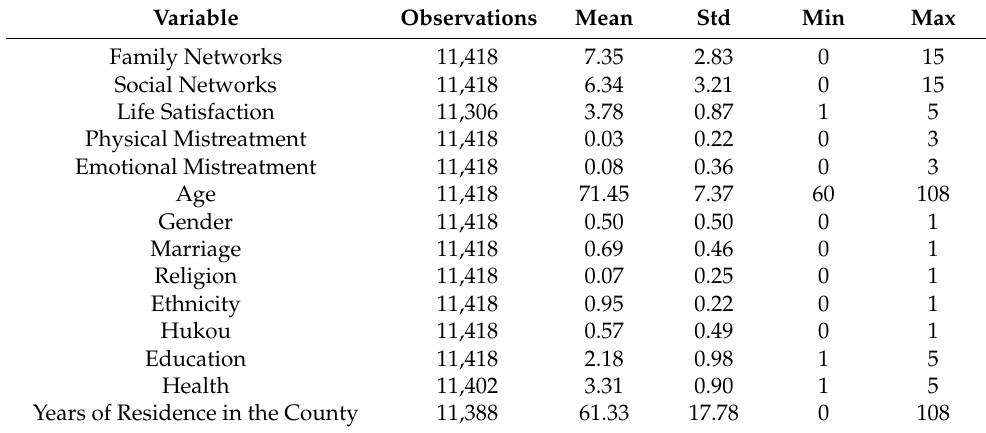
Table 1. Definition of variables and descriptive statistics.